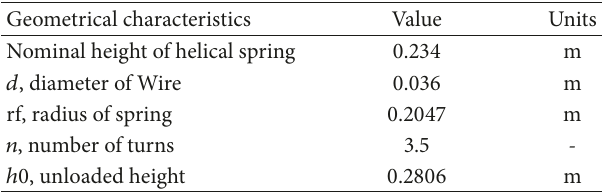
Figure 4: Detail of the axle-box guide system of the primary suspension. Table 1: Properties of the helical spring.